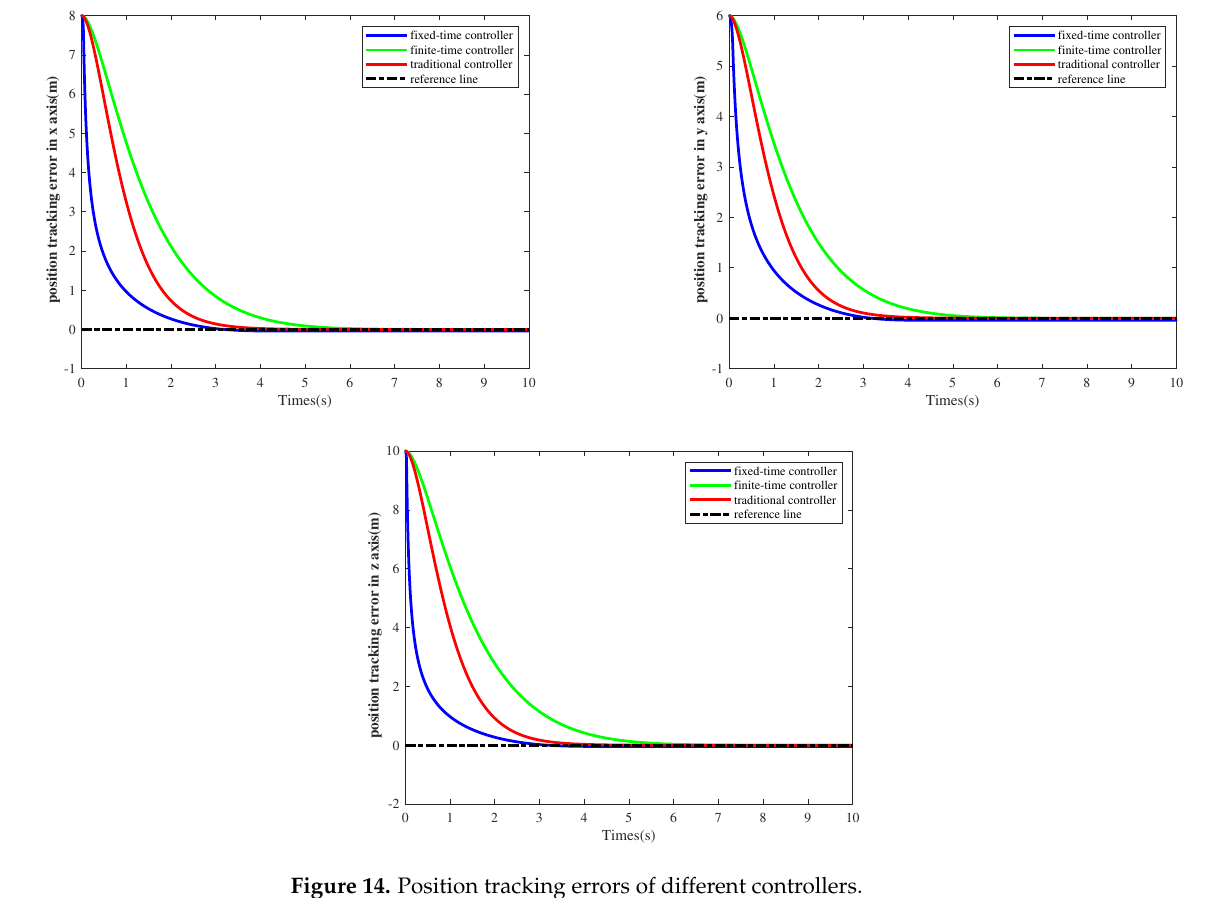
Figure 14. Position tracking errors of different controllers.